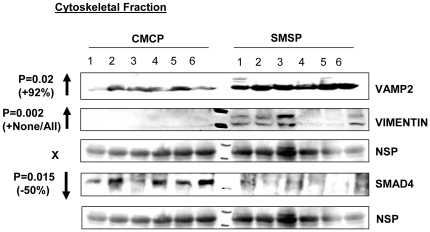
Cellular fractionation of possible target proteins: Cytoskeletal fraction.Insulin-signaling protein VAMP2 is upregulated along with the regulatory protein Vimentin, whereas SMAD4 TGF-β co-SMAD is down-regulated. NSP represents non-specific protein serving as internal control.